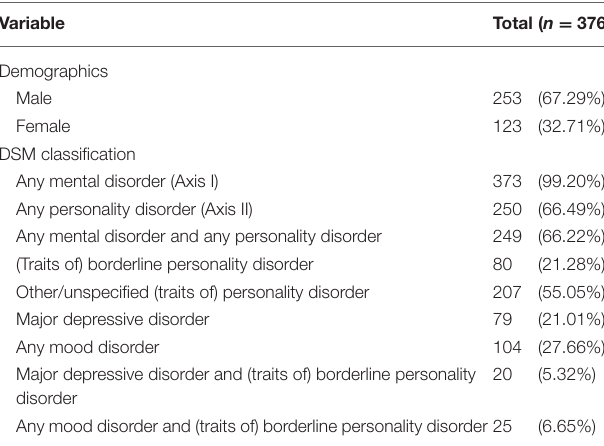
TABLE 1 | Demographic and diagnostic (DSM) characteristics of participating patients: n